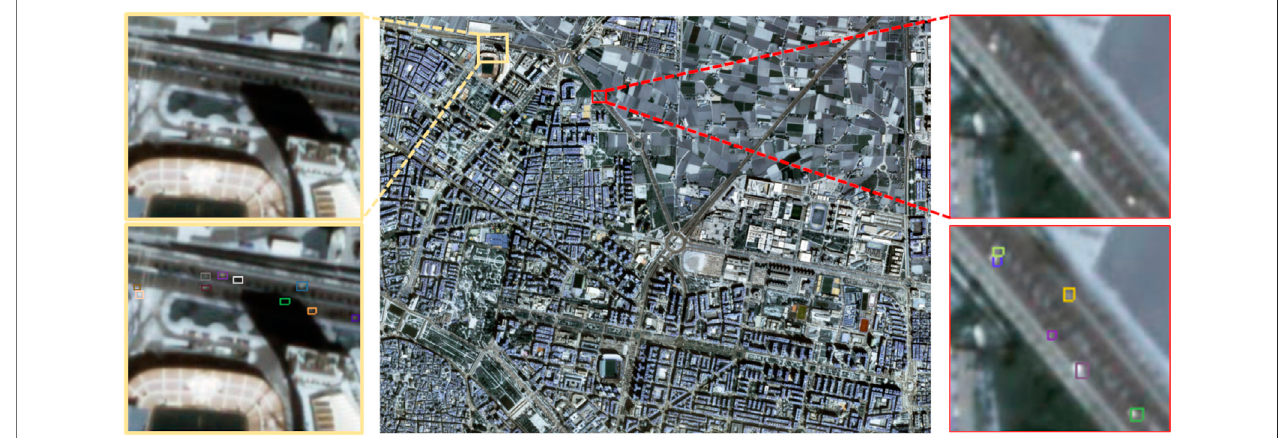
FIGURE 1 | Jilin-1 satellite image with provided annotations. Each colored box represents a target